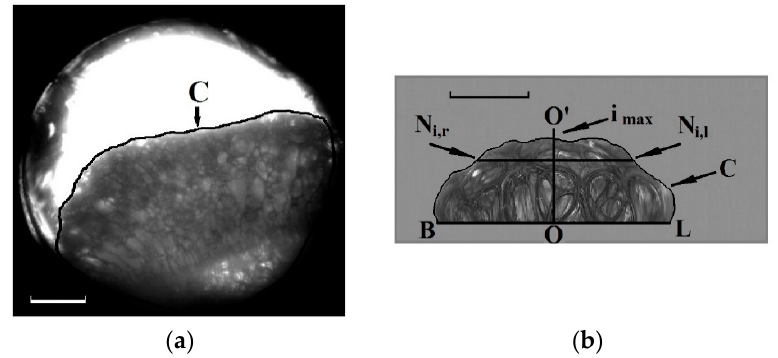
Figure 2. Typical images of the quasi-adiabatically ( a ) and quasi-isothermally ( b ) expanding foams used to recover V f ( t ) . “C” denotes the contours of the foam-occupied zones. Scale bars correspond to 1 mm ( a ) and 2 mm ( b ).